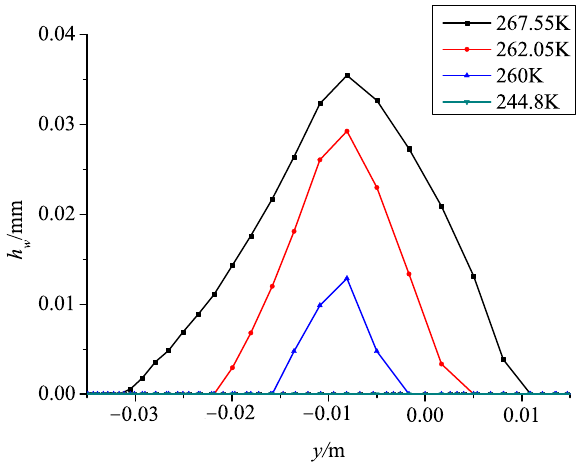
Figure 7. Distribution of water film thickness on the surface.